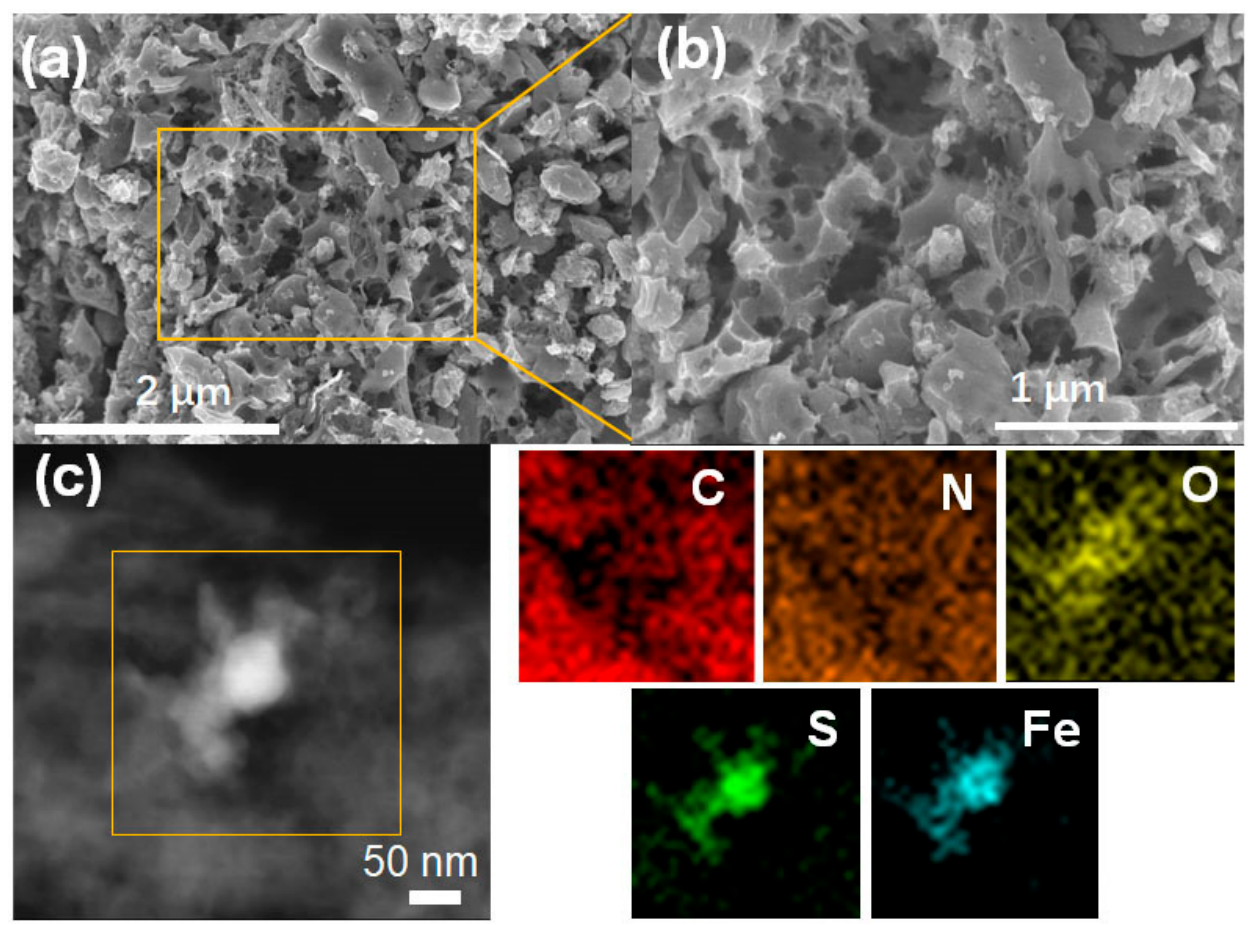
Figure 1. SEM images of ( a ) and ( b ) FeNSC-850; ( c ) the HAADF-STEM image of FeNSC-850 and its corresponding element mapping of C, N, O, S, and Fe.